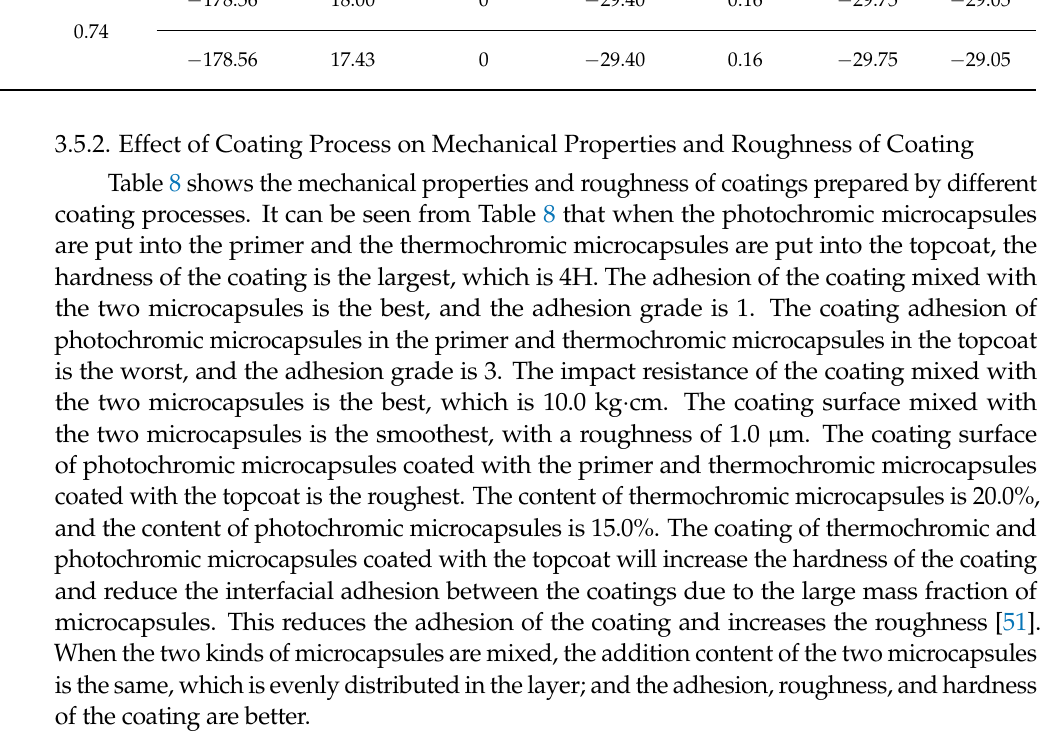
Table 8. Mechanical properties and roughness of coatings with different coating